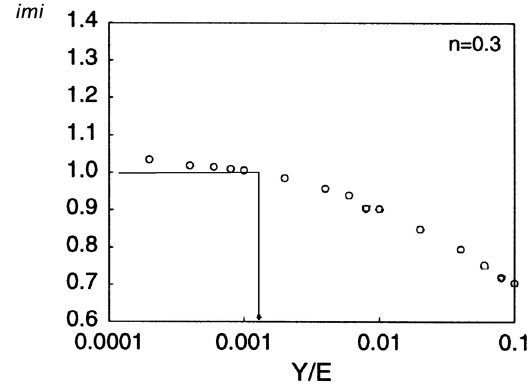
Figure 4. Numerical simulation described by Cheng and Cheng 13 showing the variation in imi with Y/E for a material with n = 0.1. Two experimental values of Y/E and the corresponding values of imi are marked.